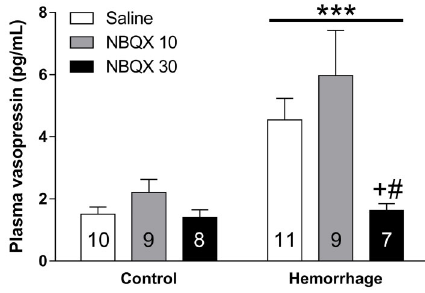
Figure 2. Intracerebroventricular administration of NBQX reverses the effect of hemorrhage on plasma arginine vasopres- sin (AVP). Thus, L-glutamate AMPA receptor signaling seems to be involved in the hemorrhage-induced AVP secretion. Data are reported as means ± SE. ***F (1,48) =15.24, P o 0.001 compared to control; + P=0.02 vs hemorrhage-saline; # P o 0.001 vs hemor- rhage-NBQX 10 (ANOVA). Numbers in columns indicate the number of animals/group.